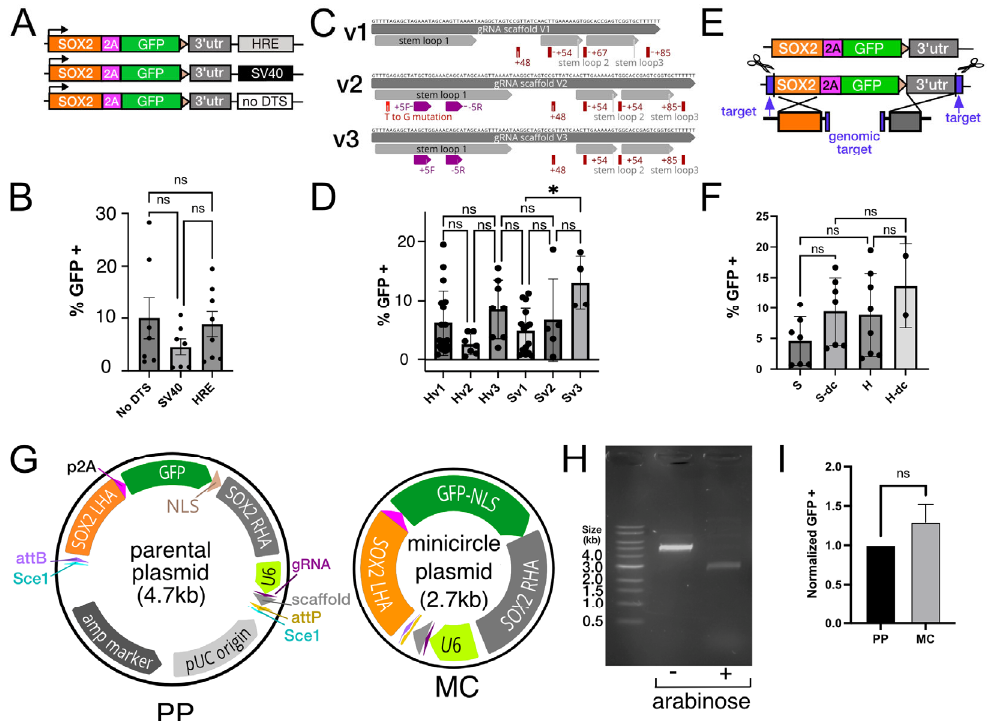
Figure 3. Donor plasmid optimization for gene-editing by homology-directed repair. ( A ) Different DNA tagging sequences (DTS) were inserted into the SOX2-GFP donor plasmids. ( B ) The role of SV40 and HRE DTS sequences on SOX2-GFP integration was assessed by measuring the number of GFP+ cells relative to DAPI+ total cells. ( C ) Three different guide RNA scaffolds based on Ran et al. (2013) [4] (V1), Dang et al. (2015) [33] (V2) and Chen et al. (2013) [34] (V3) illustrate the variation in the first stem-loop structure that interacts with Cas9. ( D ) Quantification of GFP+ cells after editing with SOX2-GFP donor plasmids harboring HRE and SV40 DTSs and the V1-3 scaffolds. ( E ) Illustration of SOX2-GFP donor fragment double cutter (dc) linearization by the introduction of SOX2 targeting sites at the distal ends of the homology arms. ( F ) Quantification of the effect of donor fragment linearization on integration in the presence of SV40 or HRE DTS fragments. ( G ) Illustration of a standard parental plasmid (PP) and a minicircle plasmid (MC) with bacterial sequence elements removed. ( H ) Agarose gel electrophoresis of Kpn1 digested PP and MC plasmids in the absence ( − ) or presence (+) of arabinose. ( I ) Comparison between PP and MC plasmids for SOX2-GFP integration. One-way ANOVA was used to test statistical significance and for multiple comparison tests, a Dunnett’s multiple comparison was used with an α cutoff of 0.05. * p < 0.05, ns = not significant.